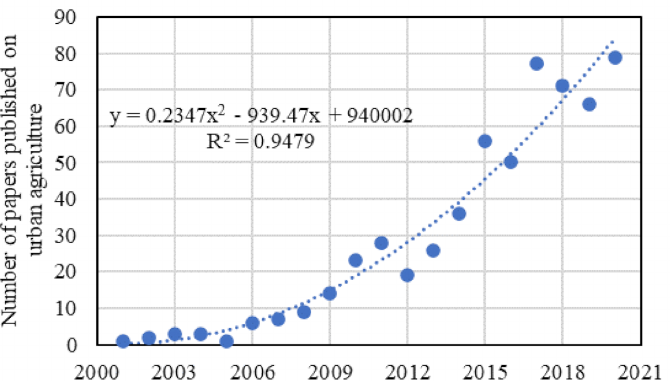
Figure 1. Number of papers published on urban agriculture from 2001 to 2020.